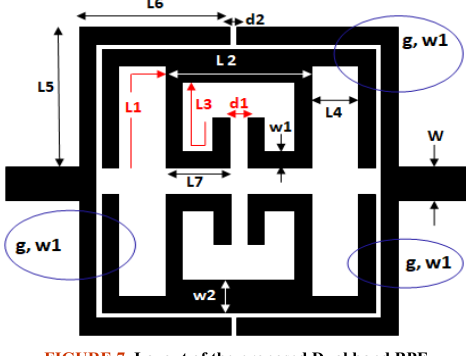
FIGURE 7. Layout of the proposed Dual band BPF